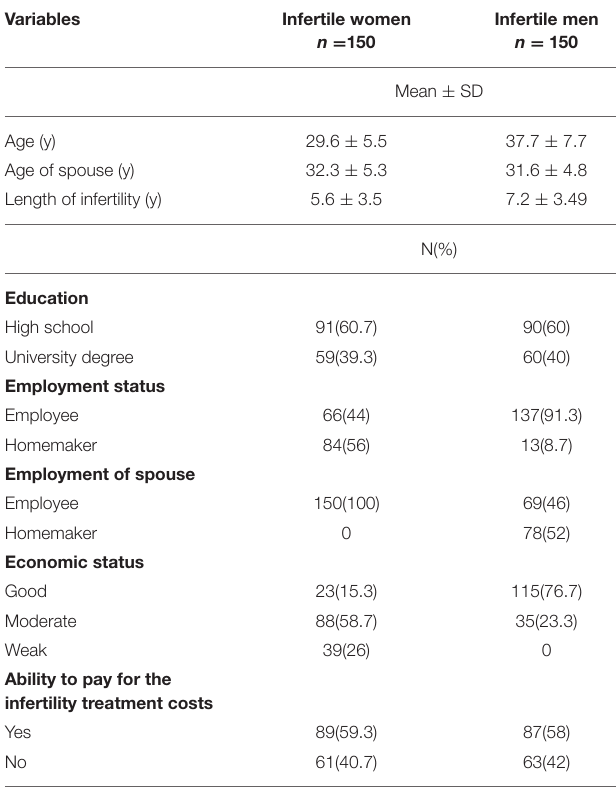
TABLE 1 | Demographic characteristics of infertile men and